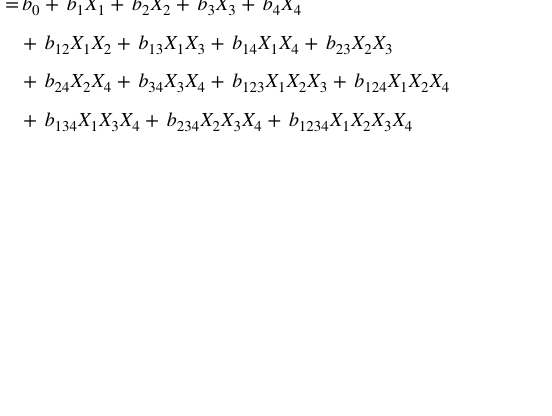
Table 2 Experimental domain for full factorial design